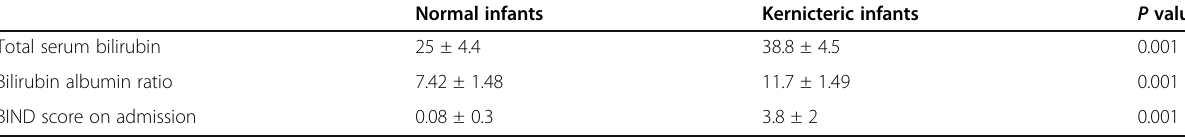
Table 4 Comparison of poor neurologic outcome, TSB, B/A ratio, and BIND scores on admission Normal